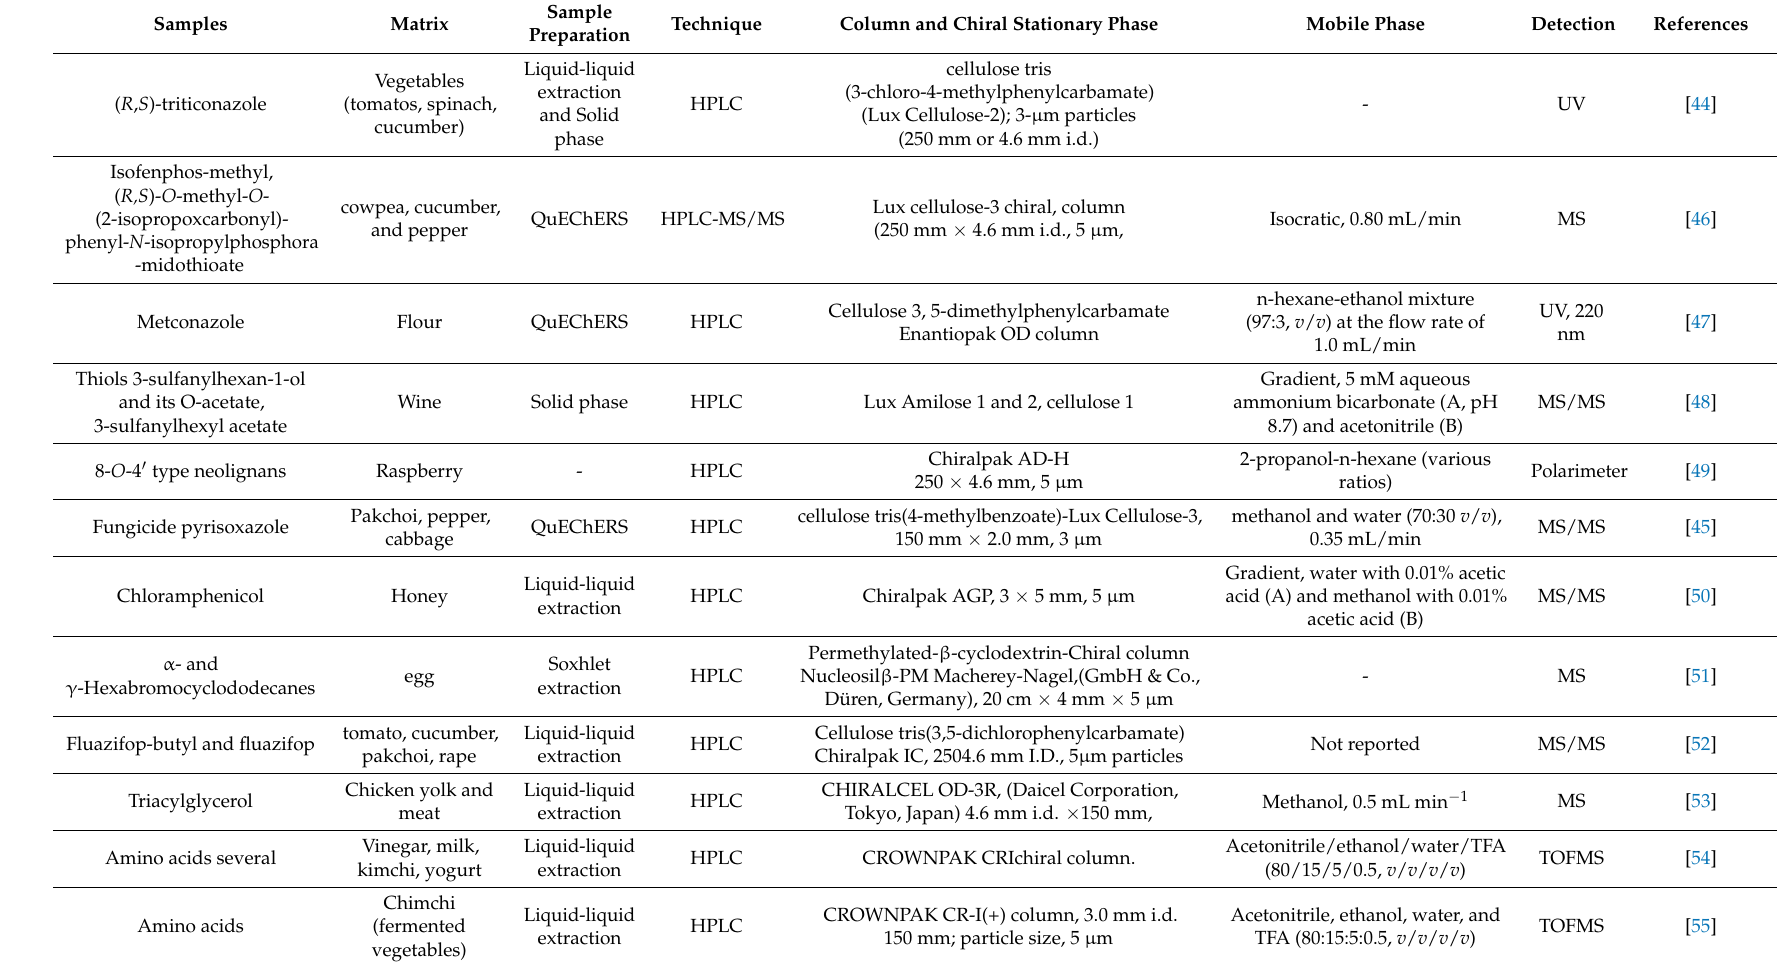
Table 2. Selected applications of HPLC to Food